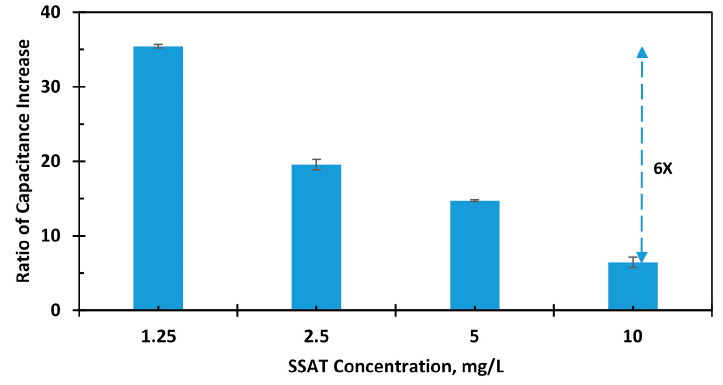
Figure 12. The ratio of increase in capacitance with various concentration of the SSAT. Table 1. Readout circuit performance summary.